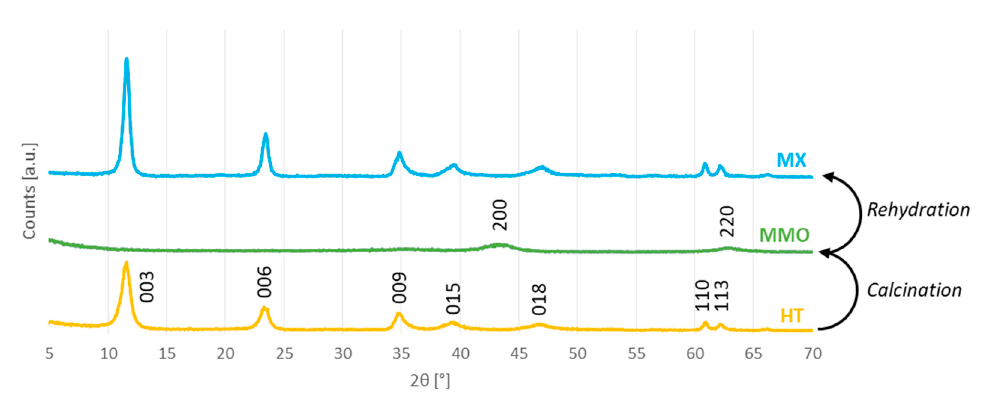
Figure 2. X-ray di ff ractograms of the prepared Figure 2. X-ray diffractograms of the prepared catalysts.